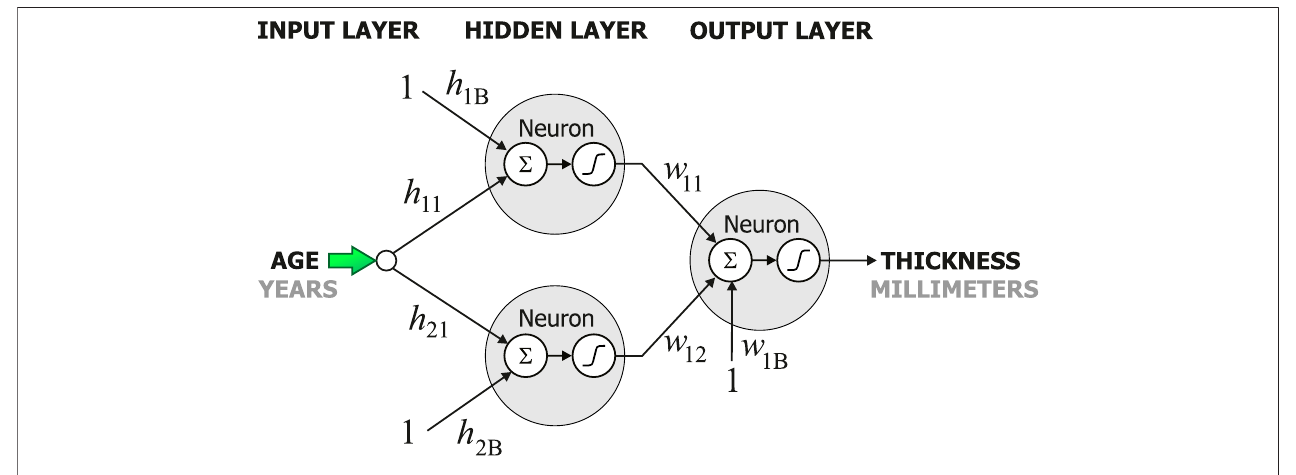
FIGURE 1 | Structure of the arti fi cial neural network used to model the cortical thickness.